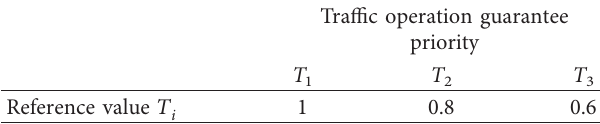
Table 4: Reference value of traffic operation guarantee